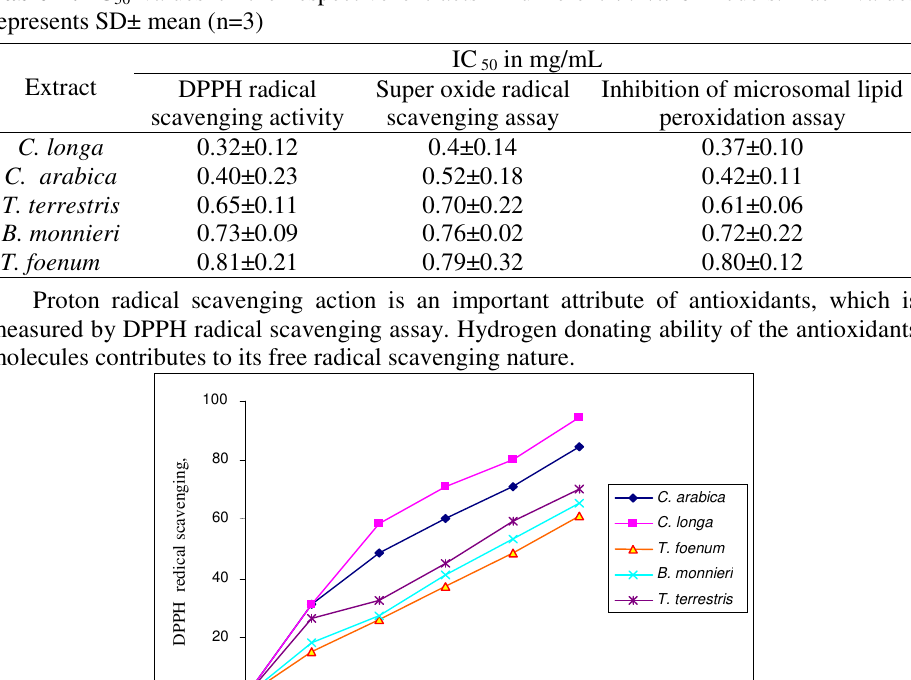
IC in mg/mL 50 Super oxide radical Inhibition of microsomal lipid scavenging assay